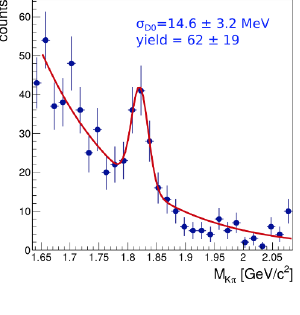
Figure 6. First direct measurement of D 0 at SPS energies.